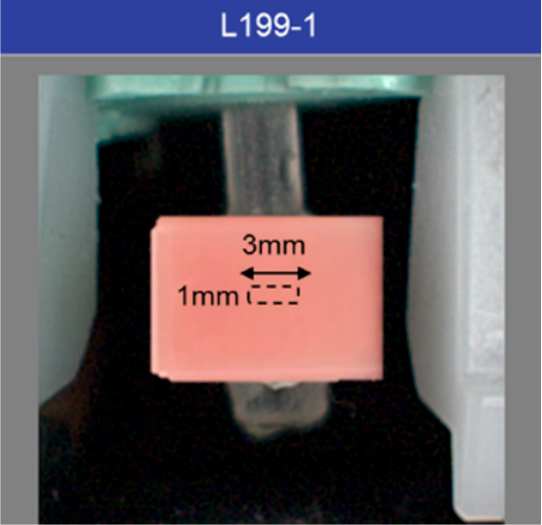
Figure 2. Spectrophotometric color measurement of gingival shade guides. The color reading of rectangular area (3 mm × 1 mm) in the center of the shade guide tab was